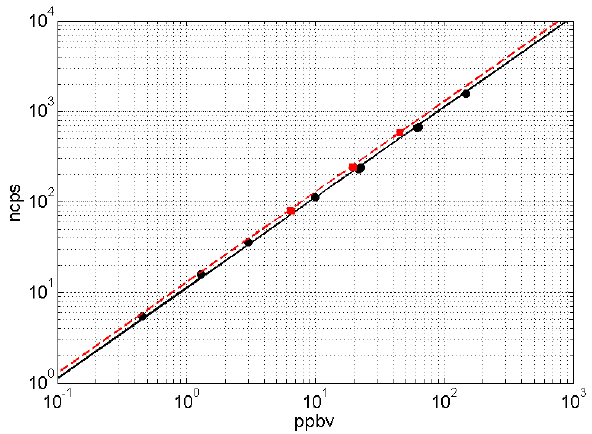
prene (black) and 232MBO (red) exhibit higher sensitivities at MBO (red) exhibit higher sensitivities at lower collisional energies. The dashed lines indicate 6